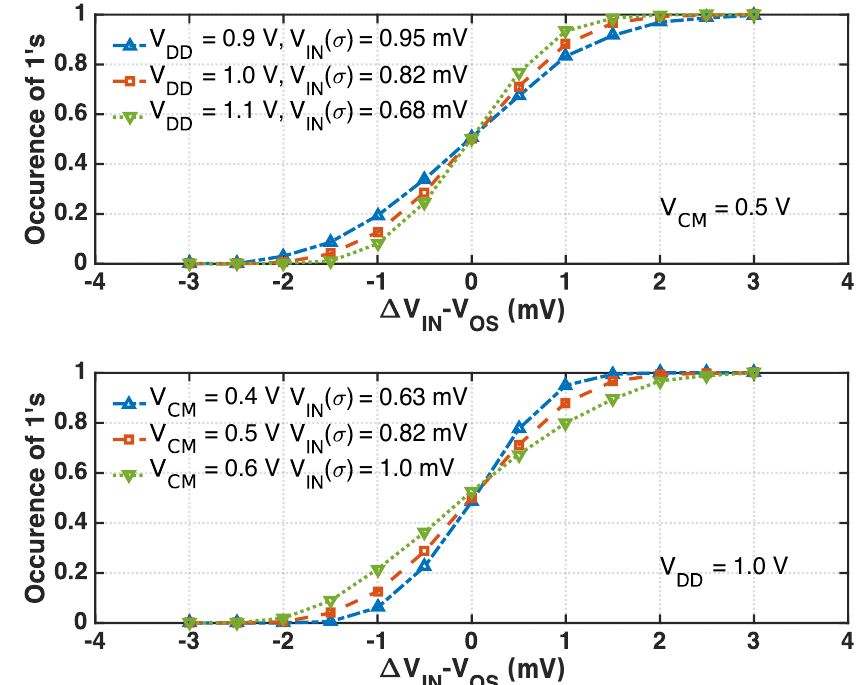
Figure 9. Measured cumulative noise distribution versus differential input at 11GHz for varying V DD ( top ) and varying V CM ( bottom